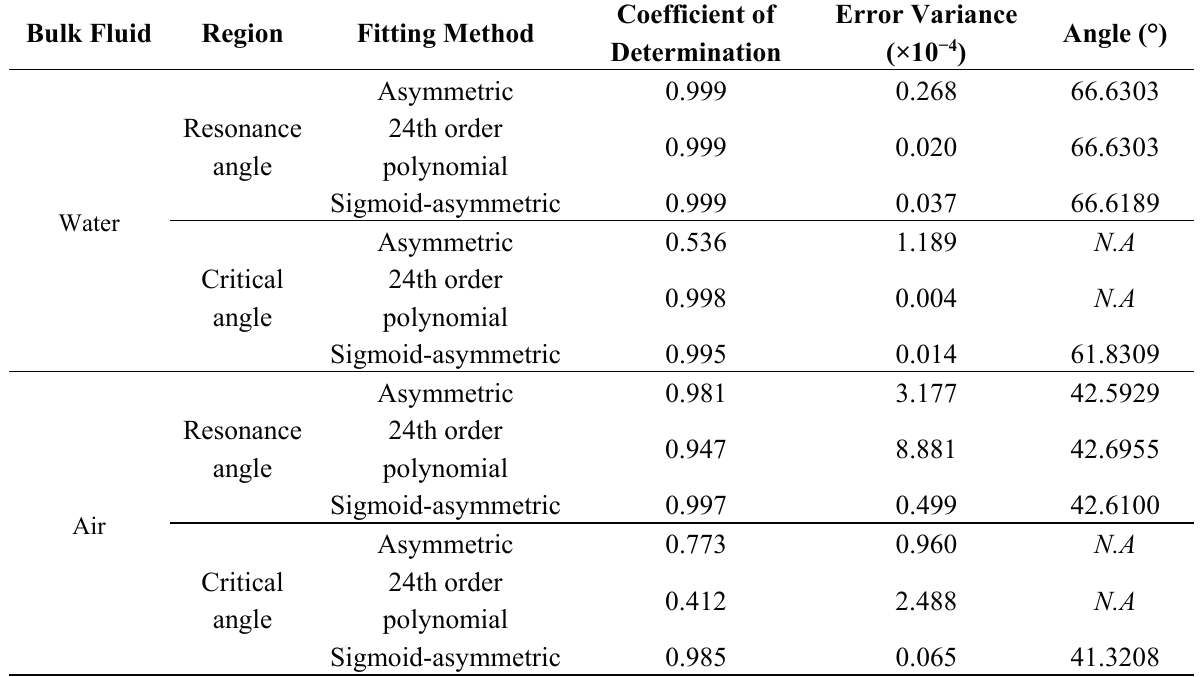
Table 1. Calculated statistical results including error variance and coefficient of determination and both angle positions obtained by fitting methods based on asymmetric, 24th-order polynomial and sigmoid-asymmetric equation for a full SPR curve. The SPR curve was experimentally obtained with water and air as bulk fluids on the sensing film, where N.A .: not